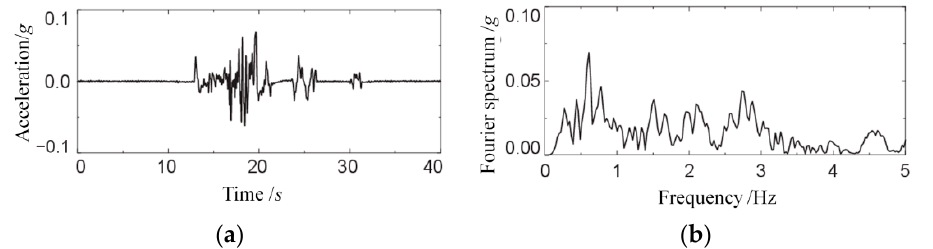
Figure 8. Acceleration records ( a ) and Fourier spectrum ( b ) of input motions on the shaking table surface.